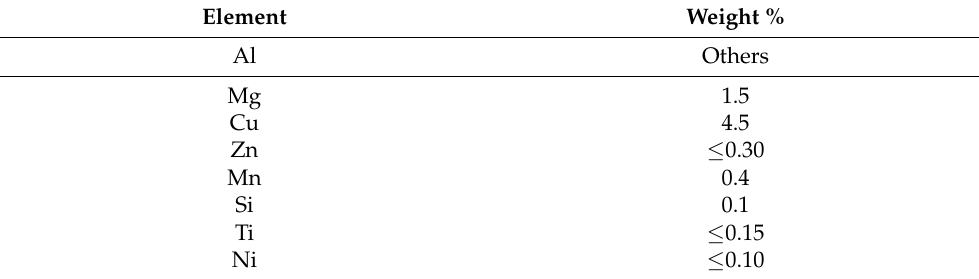
Table 1. Chemical composition.